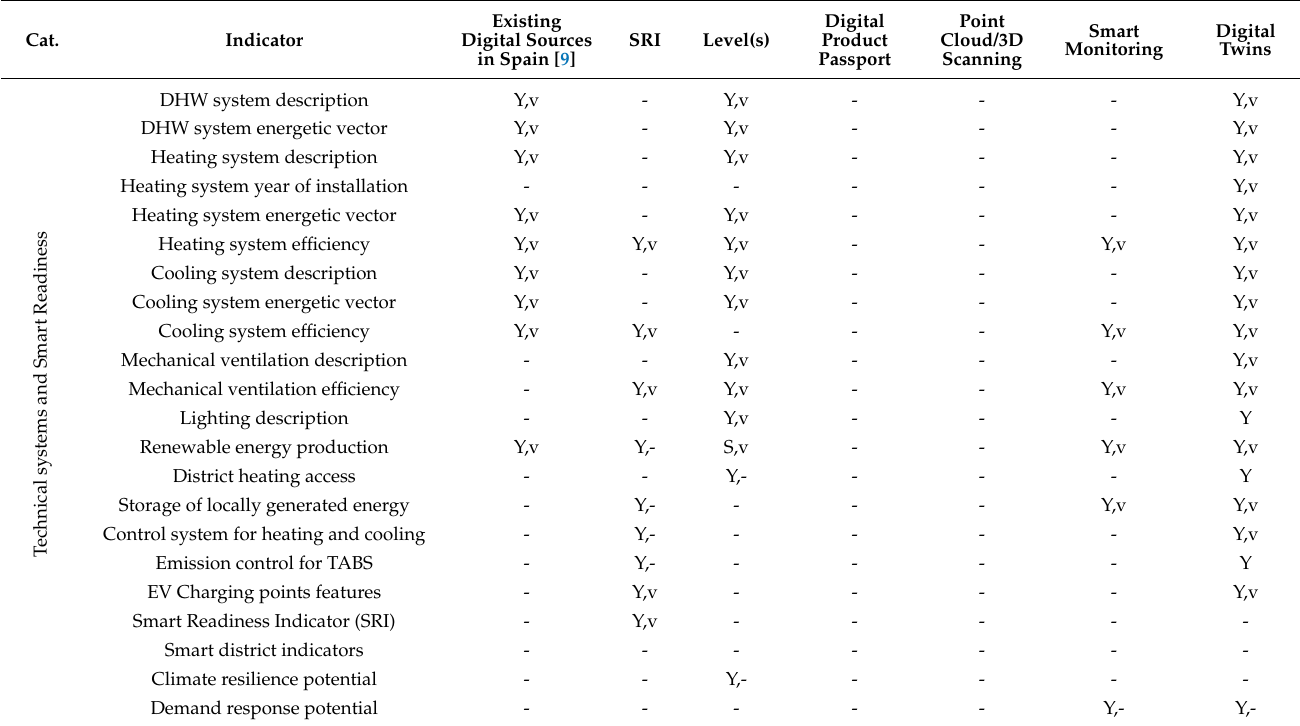
Table A3. Category 3: Technical systems and Smart Readiness.